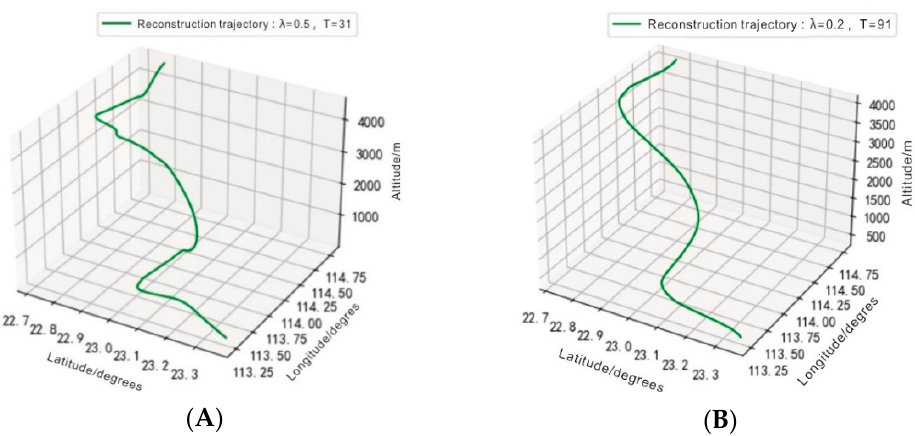
Figure 5. Reconstruction trajectory. ( A ) Reconstruction trajectory with λ = 0.5, T = 51. ( B ) Recon- struction trajectory with λ = 0.2, T = 91.